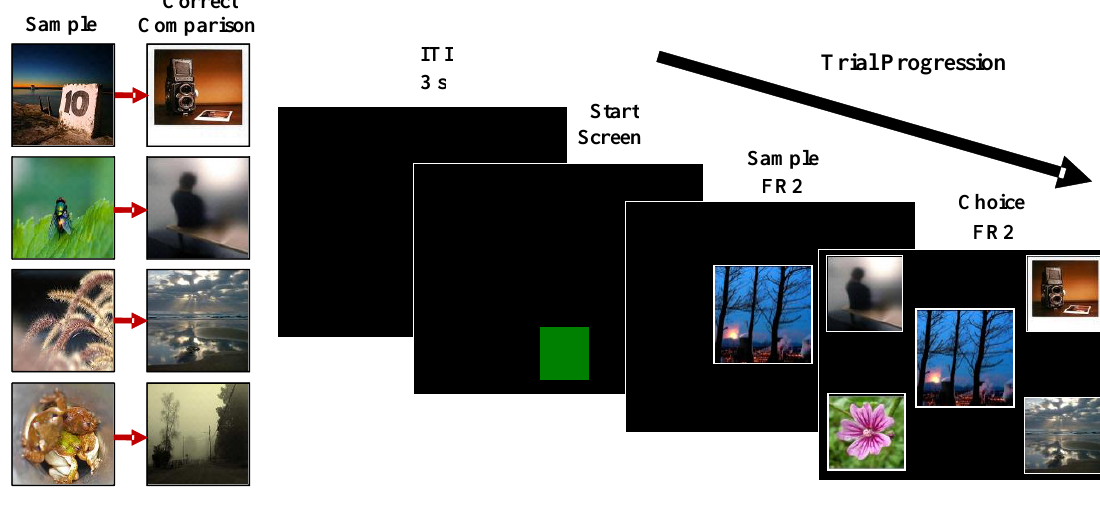
Figure 1. Stimuli ( left ) and trial progression ( right ) for Experiment 1. Left. Pre-trained known paired associates used in Experiment 1. Right. Example of an exclusion trial from Experiment 1. Monkeys initiated trials by touching the green start box. A sample image appeared in the center of the screen. After this image was touched, four comparison images appeared randomly in the four corners of the screen. On exclusion trials, selection of the novel comparison image (lower left corner in the figure) from among the three known images resulted in a reward, whereas choice of one of the incorrect known comparison images resulted in a time-out period and no